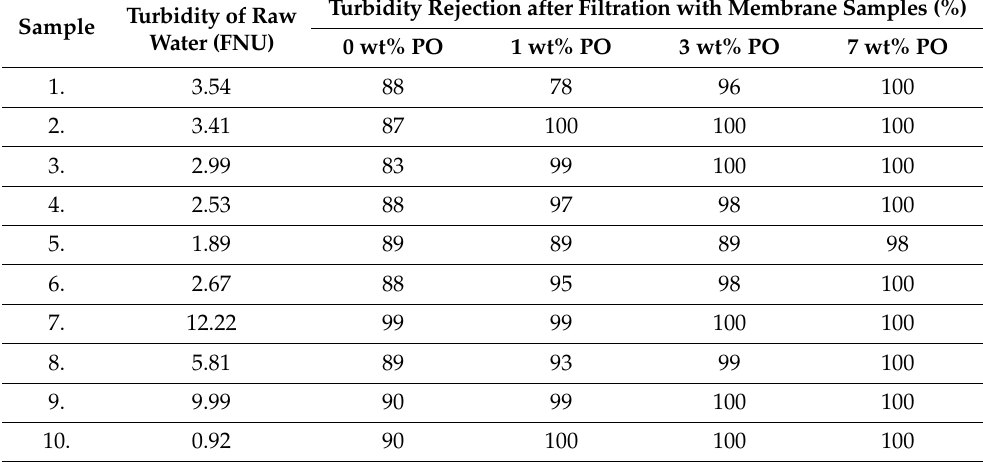
Table 1. Removal efficiency of turbidity of well water after filtrated by